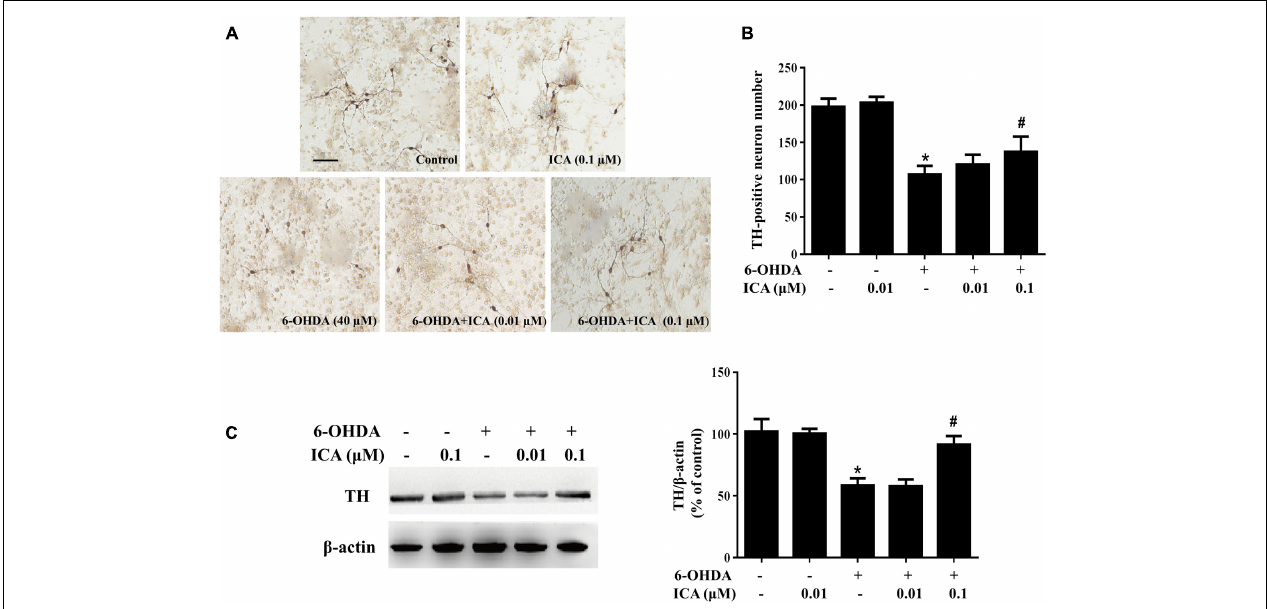
FIGURE 2 | Icariin protected DA neurons against 6-OHDA-induced neurotoxicity in vitro . Rat primary midbrain neuron-glia cultures we re pretreated with ICA (0.01 and 0.1 µ M) for 30 min before the treatment of 6-OHDA (40 µ M). Seven days later, ICA-elicited neuroprotection was quantified by TH-positive neuron counting (B) through the immunocytochemical analysis. Representative images of immunostaining from three individual experiments were shown (A) . Scale bar: 100 µ m. The level of TH protein expression in the neuron-glia cultures was measured with western blot analysis (C) . The ratio of densitometry values of TH with β -actin was assessed and normalized to each respective control group. Results were the mean ± SEM from three independent experiments performed in triplicate. ∗ p < 0.05 compared with the control cultures; # p < 0.05 compared with 6-OHDA-treated